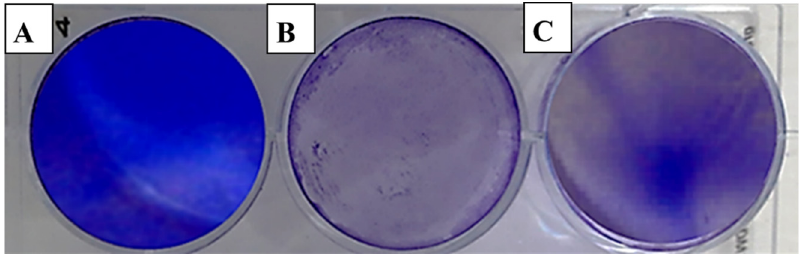
Figure 4. Effect of clove essential oil on plaque formation by the adenovirus in cell culture using the plaque reduction assay: ( A ) Vero cells (control); ( B ) Vero cells infected with adenovirus and treated with oil; ( C ) Vero cells infected with the adenovirus (infection control).